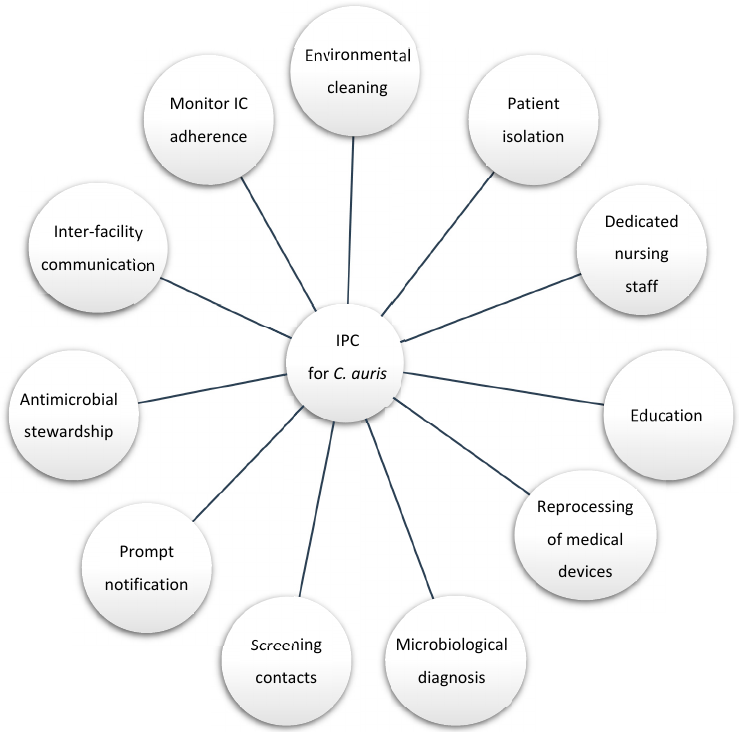
Figure 1. Infection control practice (IPC) and stewardship cornerstone for C. auris management.